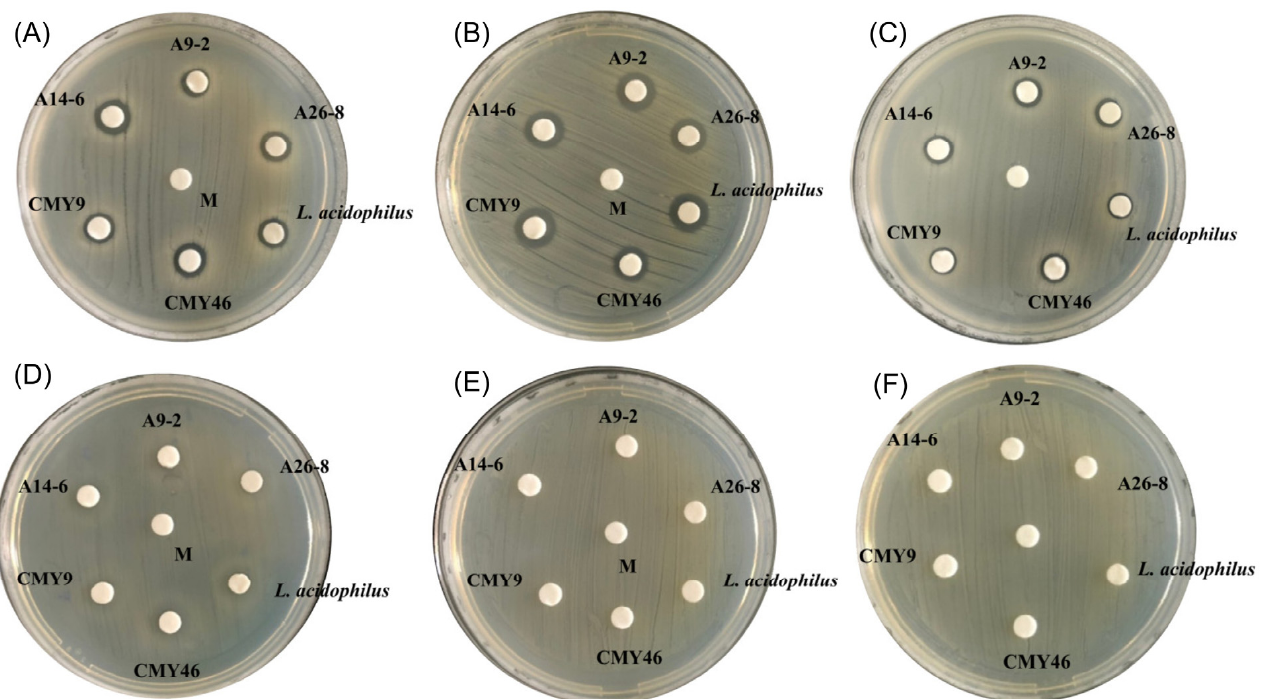
Figure 2. Disc diffusion assay of cell-free culture supernatants (CFCS), obtained from L. plantarum A9-2, L. pentosus A14-6, L. pentosus A26-8, P. pentosaceus CMY9, L. pentosus CMY46, and L. acidophilus culture in MRS broth (M) uninoculated MRS broth, against Bacillus cereus ( A , C ), Staphylococcus aureus ( B , E ), Salmonella Typhimurium ( C , F ). ( A – C ): unneutralized CSCF, ( D – F ): neutralized CFCS (pH 7).